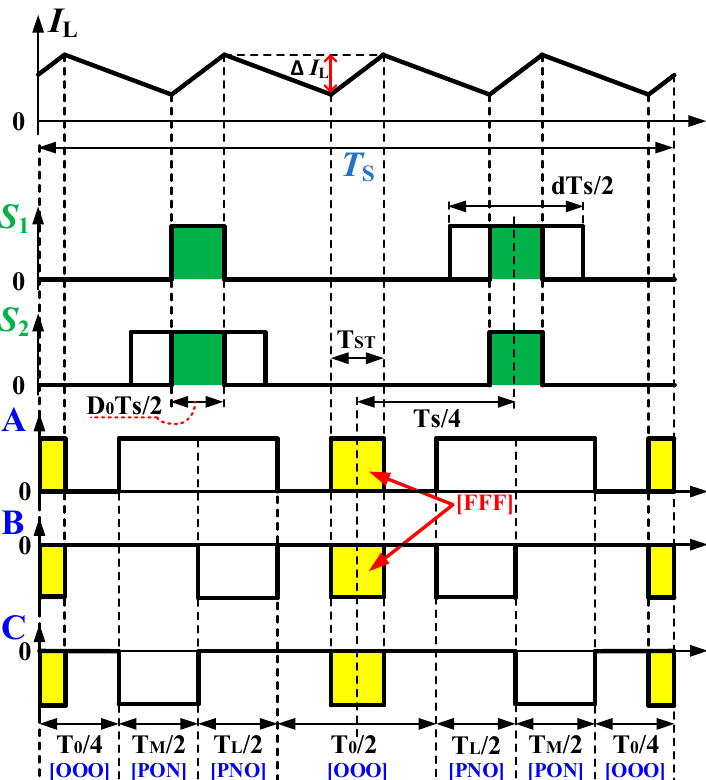
Figure 4. Switching sequence in sector I and control signals of S 1 and S 2 .